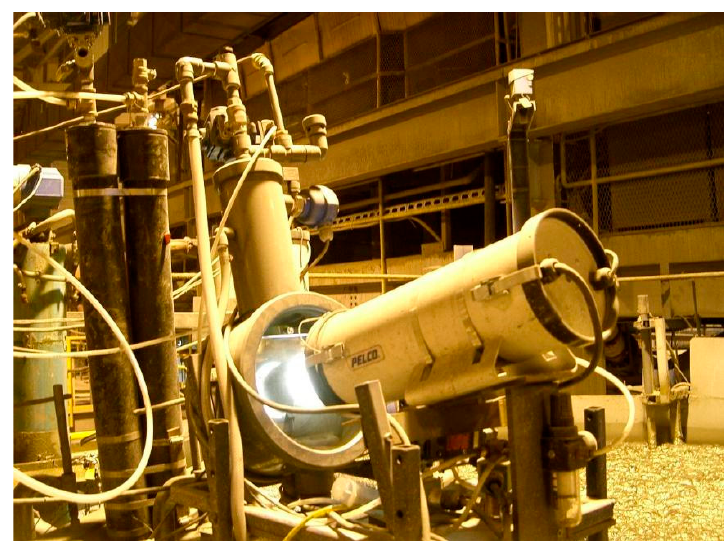
Figure 2. Bubble viewer setup on the flotation vessel.